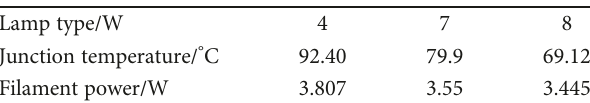
Figure 3: Junction temperatures of the A60 LED fi lament lamps (4 W, 7W, and 8 W) with di ff erent helium in fl ating ratios. Table 2: A60 LED fi lament lamp junction temperatures and fi lament lamps under 4 W-driven